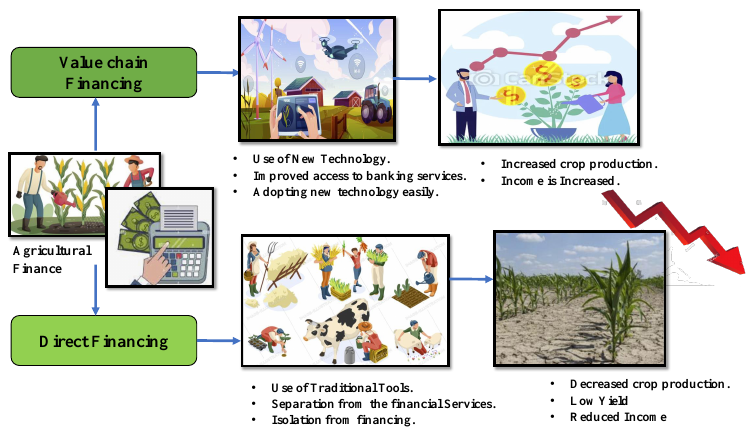
Figure 12. Impact of Agricultural Finance on Agricultural